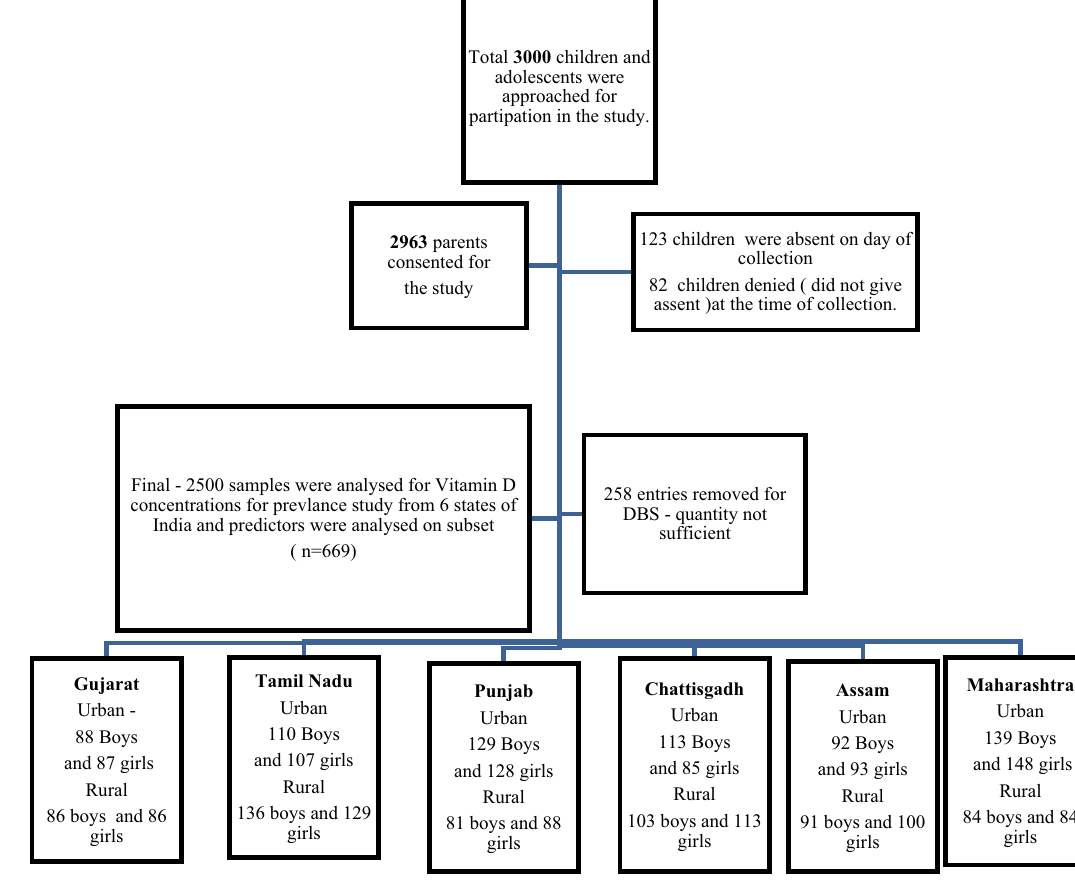
Figure 1. Flow diagram of study participants.